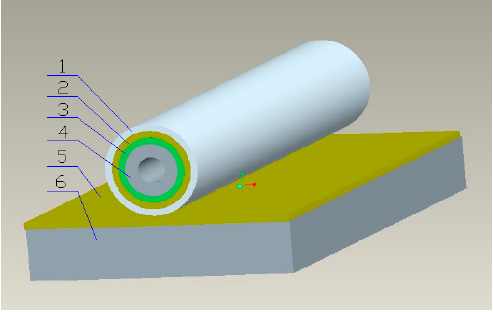
Figure 1. Three-dimensional structure of tubular electrode of direct methanol fuel cell (DMFC).